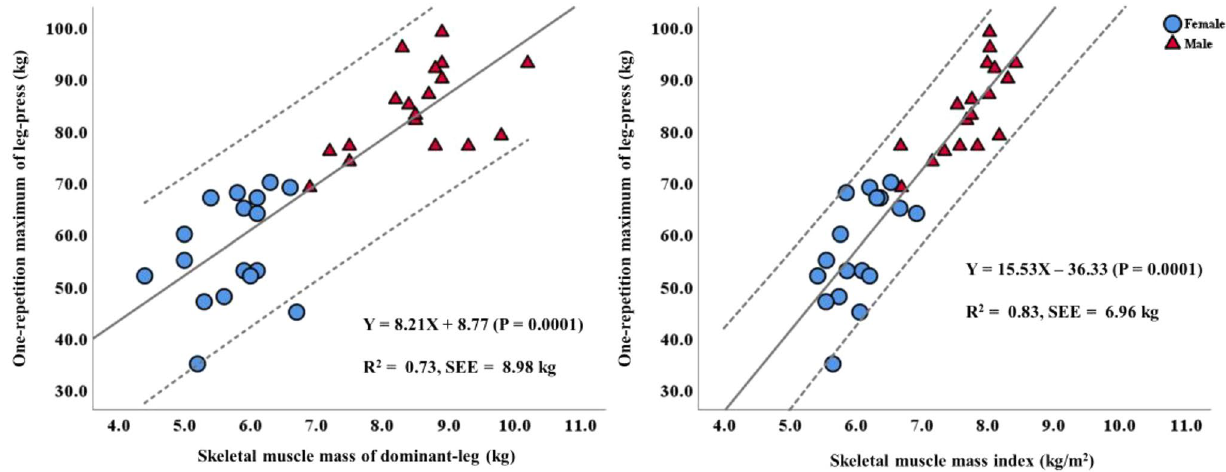
Figure 1. Regression models for one-repetition maximum for leg-press from using BIA measurements. ( a ) Skeletal muscle mass of the dominant leg. ( b ) Skeletal muscle mass index. The dotted lines represent the 95% confidence